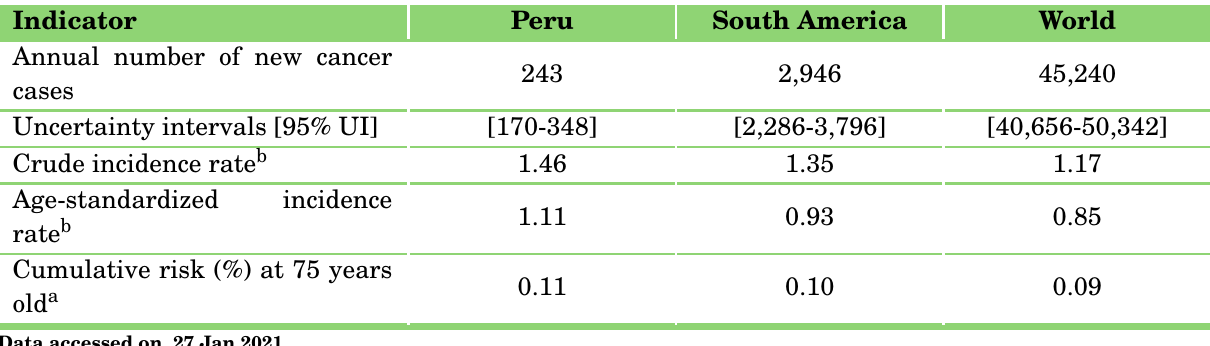
Table 9: Vulva cancer incidence in Peru (estimates for